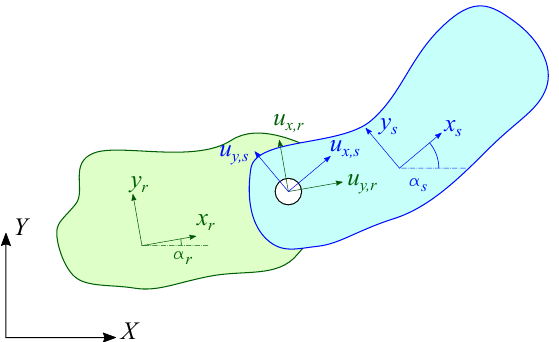
Figure 1. Two bodies r and s connected by a revolute joint in the plane orthogonal to the revolute joint axis: local ( x r y r and x s y s ) and global ( XY ) reference